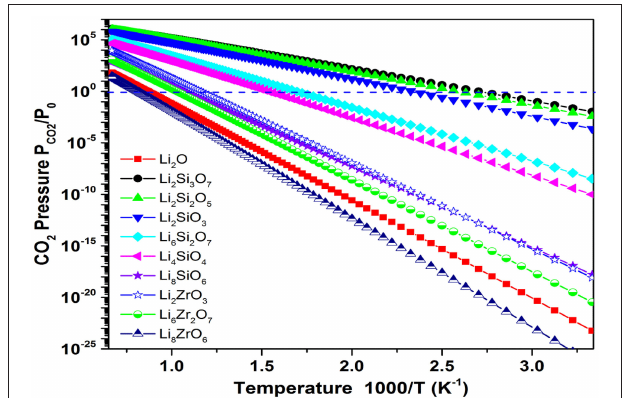
FIGURE 4 | Plots of the calculated free energy vs. CO 2 pressures and temperatures for the CO 2 capture reaction by MgO + Na 2 CO 3 (or Na 2 O) to form the double salt Na 2 Mg(CO 3 ) 2 . Y-axis plotted in logarithm scale. The line shows 1 G(T, P) = 0. For each reaction, above its 1 G(T, P) = 0 curve, its 1 G < 0, which means the solids absorb CO 2 and the reaction goes forward, whereas below the 1 G(T, P) = 0 curve, its 1 G > 0, which means the CO 2 starts to release and the reaction goes backward to regenerate the sorbents.